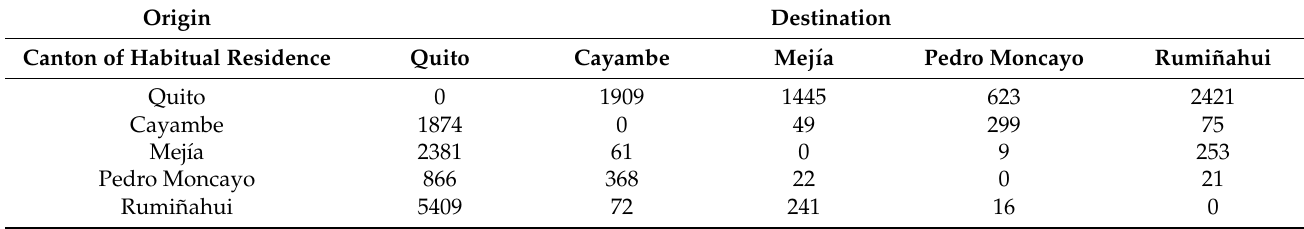
Table 3. Migratory movements between Quito and surrounding cantons in